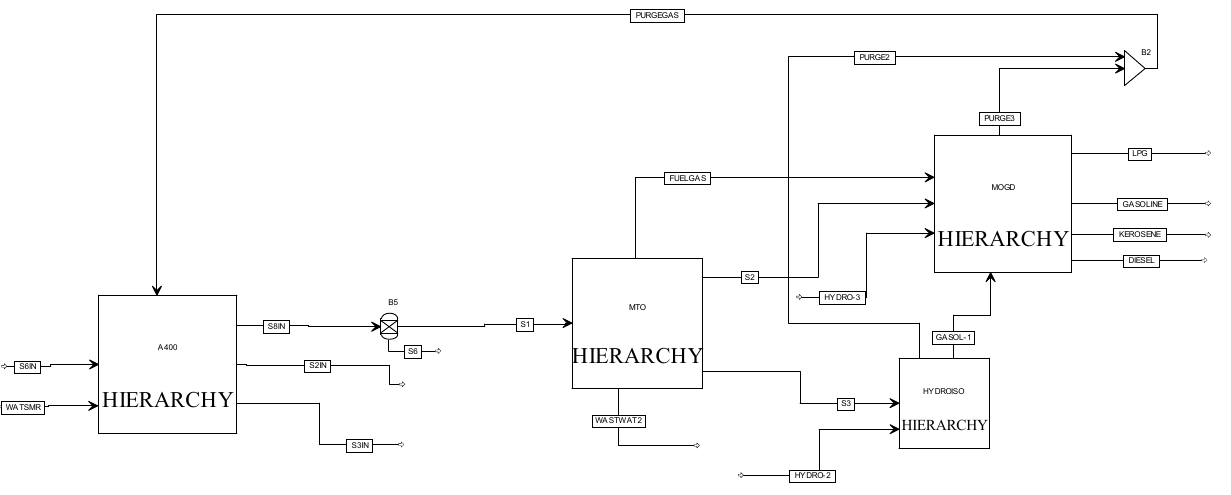
Figure A6. Aspen flowsheet of the methanol conversion and upgrading model. Tables A1 and A2 present the main results of the plant process for the remaining cases. Table A1. Main stream results of the plant process for case 1 (80% LEG–20%